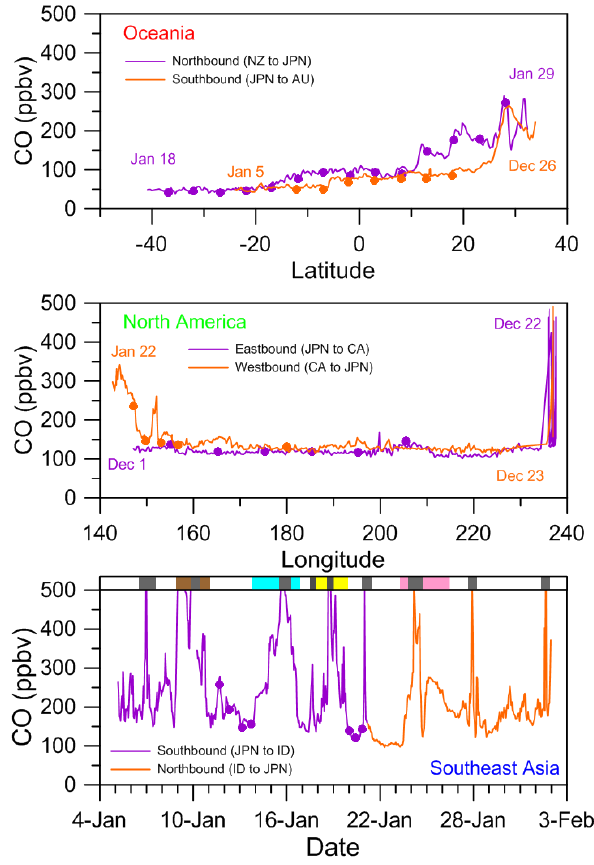
Figure 6. Variations of CO mixing ratio observed by the three ships from December 2008 to January 2009 as a function of latitude (Oceania route), longitude (North America route), and date (Southeast Asia route): continuous data (lines) and flask analysis data (solid circles). Four distinct CO increase episodes are indicated by color coding across the top of the bottom panel: episode 1, brown; episode 2, cyan; episode 3, yellow; episode 4, pink. Gray denotes the ship’s berthing at each port. For more details, see Sect. 5.